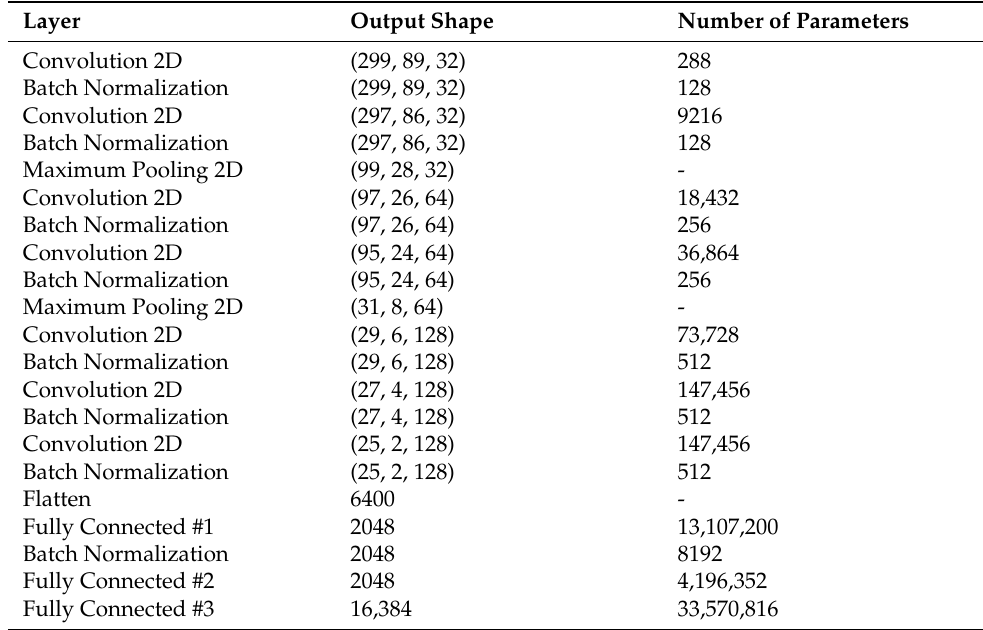
Table 2. Properties of the proposed CNN-based model